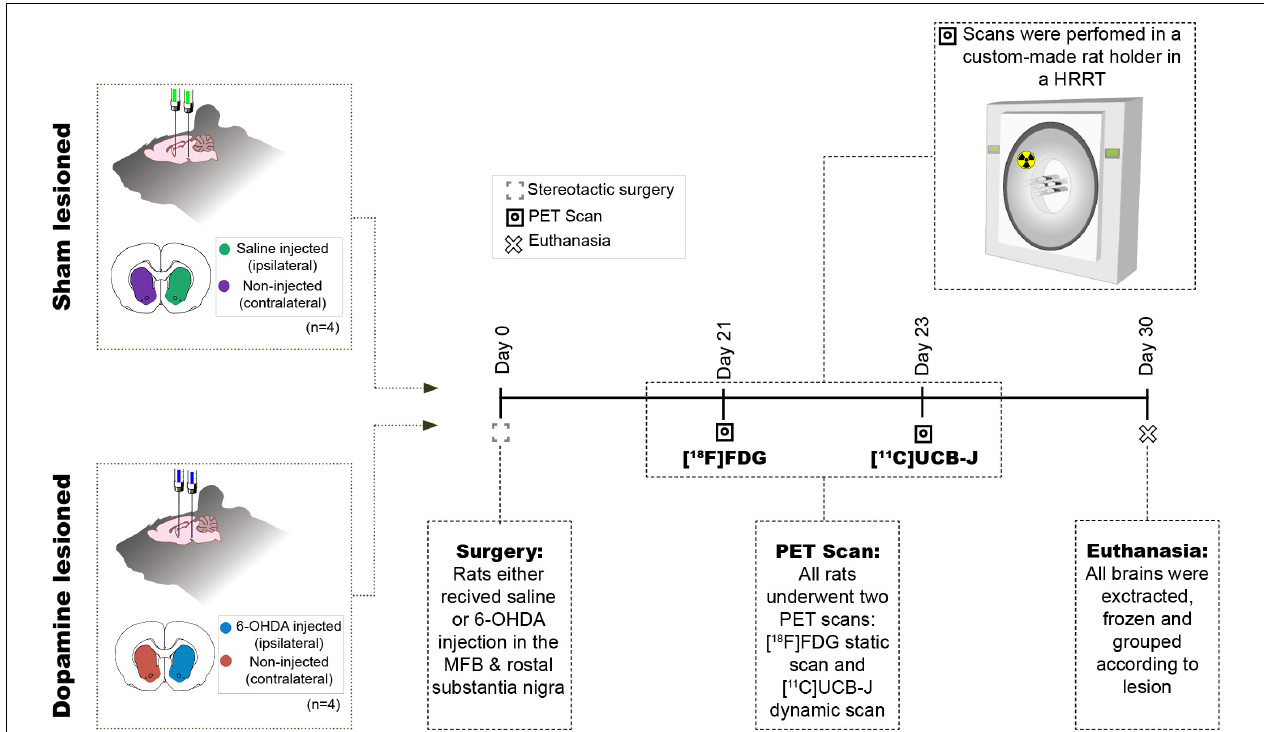
FIGURE 1 | Study design. Eight rats received two intracranial injections of either 6-OHDA or saline in the medial forebrain bundle (MFB) and rostral to substantia nigra and hence divided into two groups sham lesioned (saline) or dopamine lesioned (6-OHDA). Approximately 21 days after the injections, all rats underwent an [ 18 F]FDG PET scan followed by [ 11 C]UCB-J PET scan 2 days after in a Siemen’s high-resolution research tomography (HRRT). All animals were euthanised 30 days after the intracranial